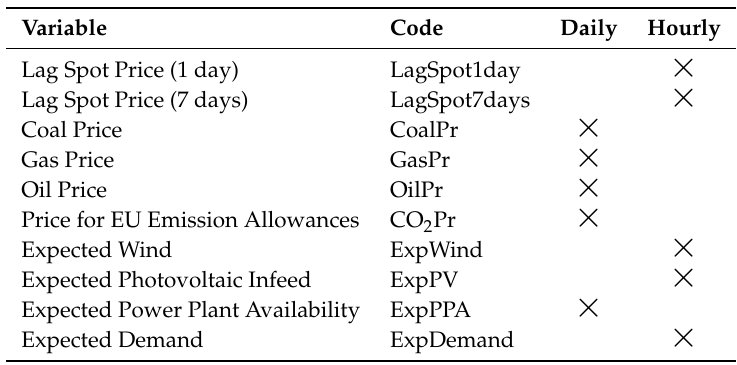
Table 3. Data granularity of fundamental